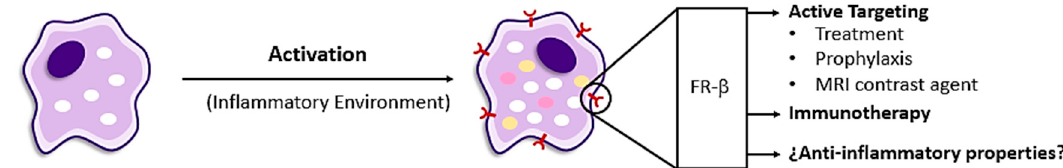
Figure 3. B-vitamins in inflammatory diseases. A schematic diagram summarizing the different mechanisms of action of folic acid for treatment or prophylaxis of inflammatory